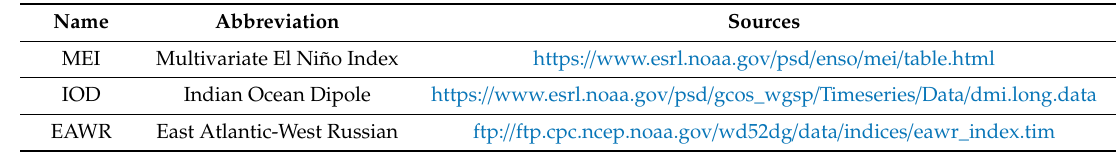
Table 1. Names and the sources of climate models used in this study.